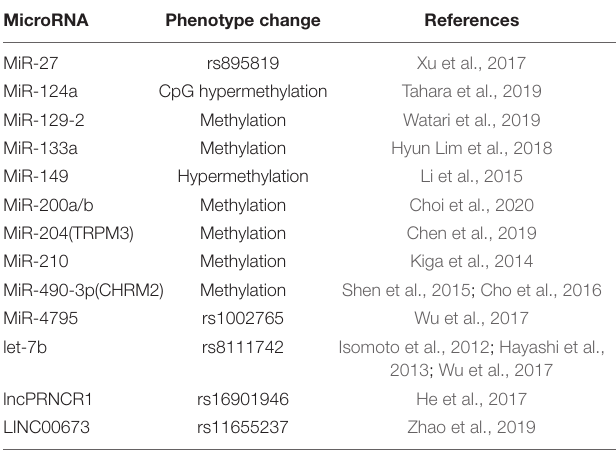
TABLE 1 | Associated phenotype alteration in non-coding